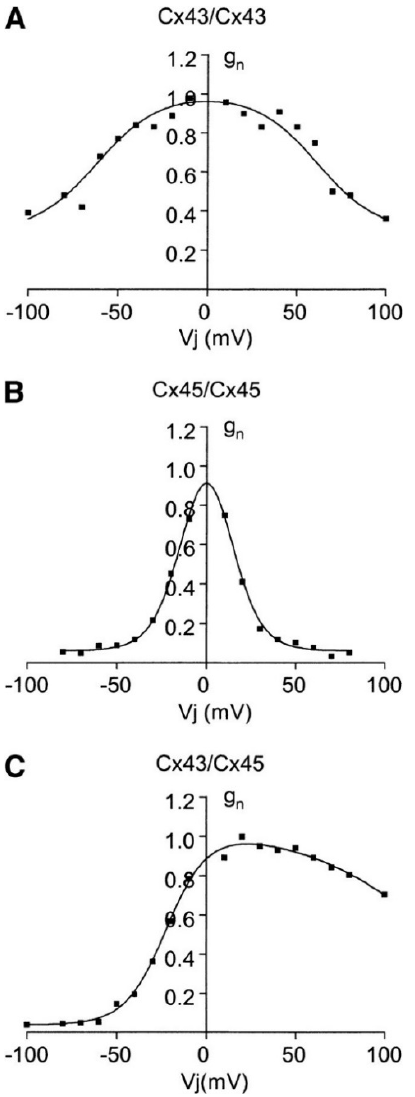
Figure 1. Normalized experimental junction conductances (g n ) vs. voltage (Vj) of the homotypic Cx43/Cx43 ( A ) and Cx45/Cx45 ( B ) channels and the heterotypic Cx43/Cx45 ( C ) channel. Homotypic channels show symmetric conductances with different voltage-gated curve sharpness while the het- erotypic Cx43/Cx45 channel shows an asymmetric conductance with an off-center peak. Reproduced with permission from [40]: Chen-Izu, Y.; Moreno, A.P.; Spangler, R.A. Opposing gates model for voltage gating of gap junction channels. Am. J. Physiol. Cell Physiol. 2001 , 281 , C1604–C1613.